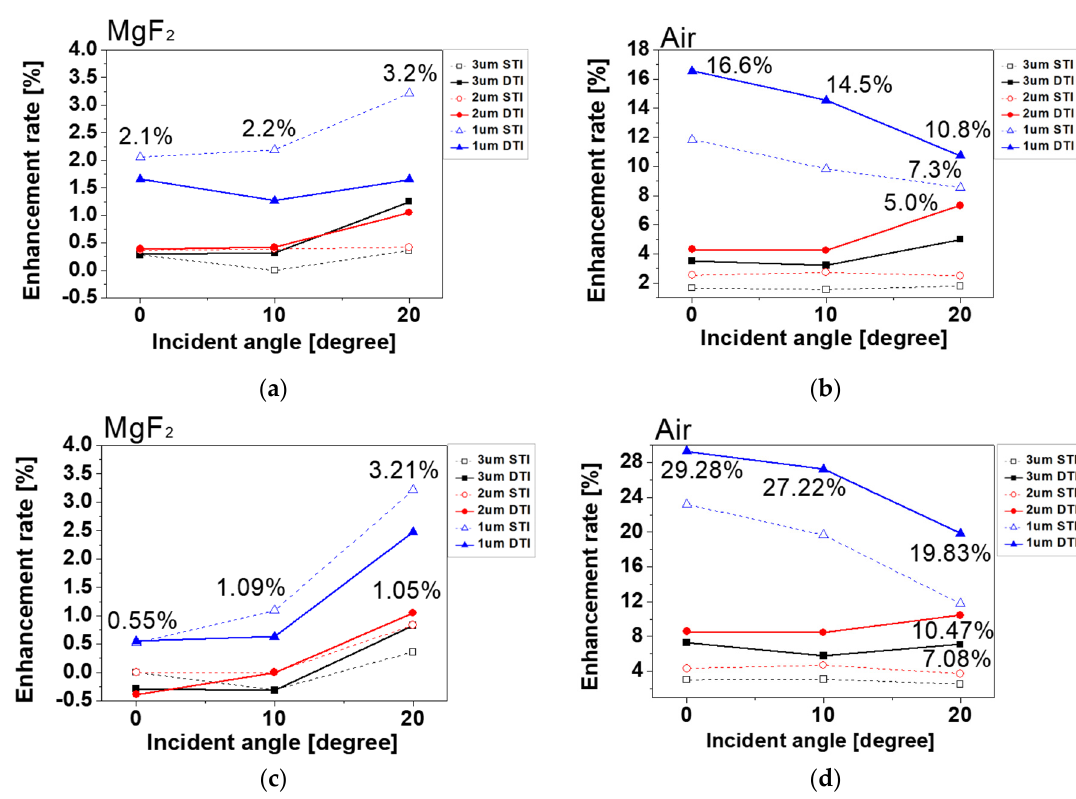
Figure 4. Simulation results of the enhancement rate incident angles of 0°, 10°, and 20°. Pixel depths